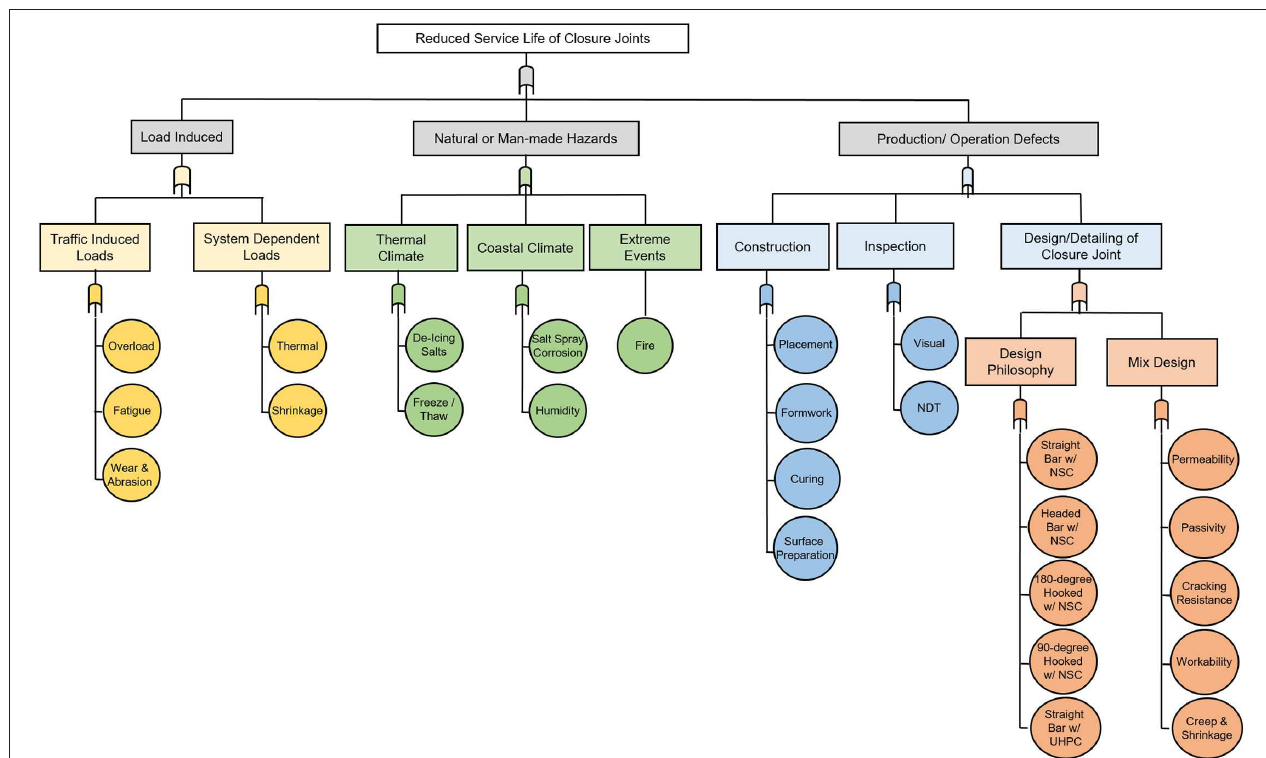
FIGURE 3 | Reduced service life fault tree of closure